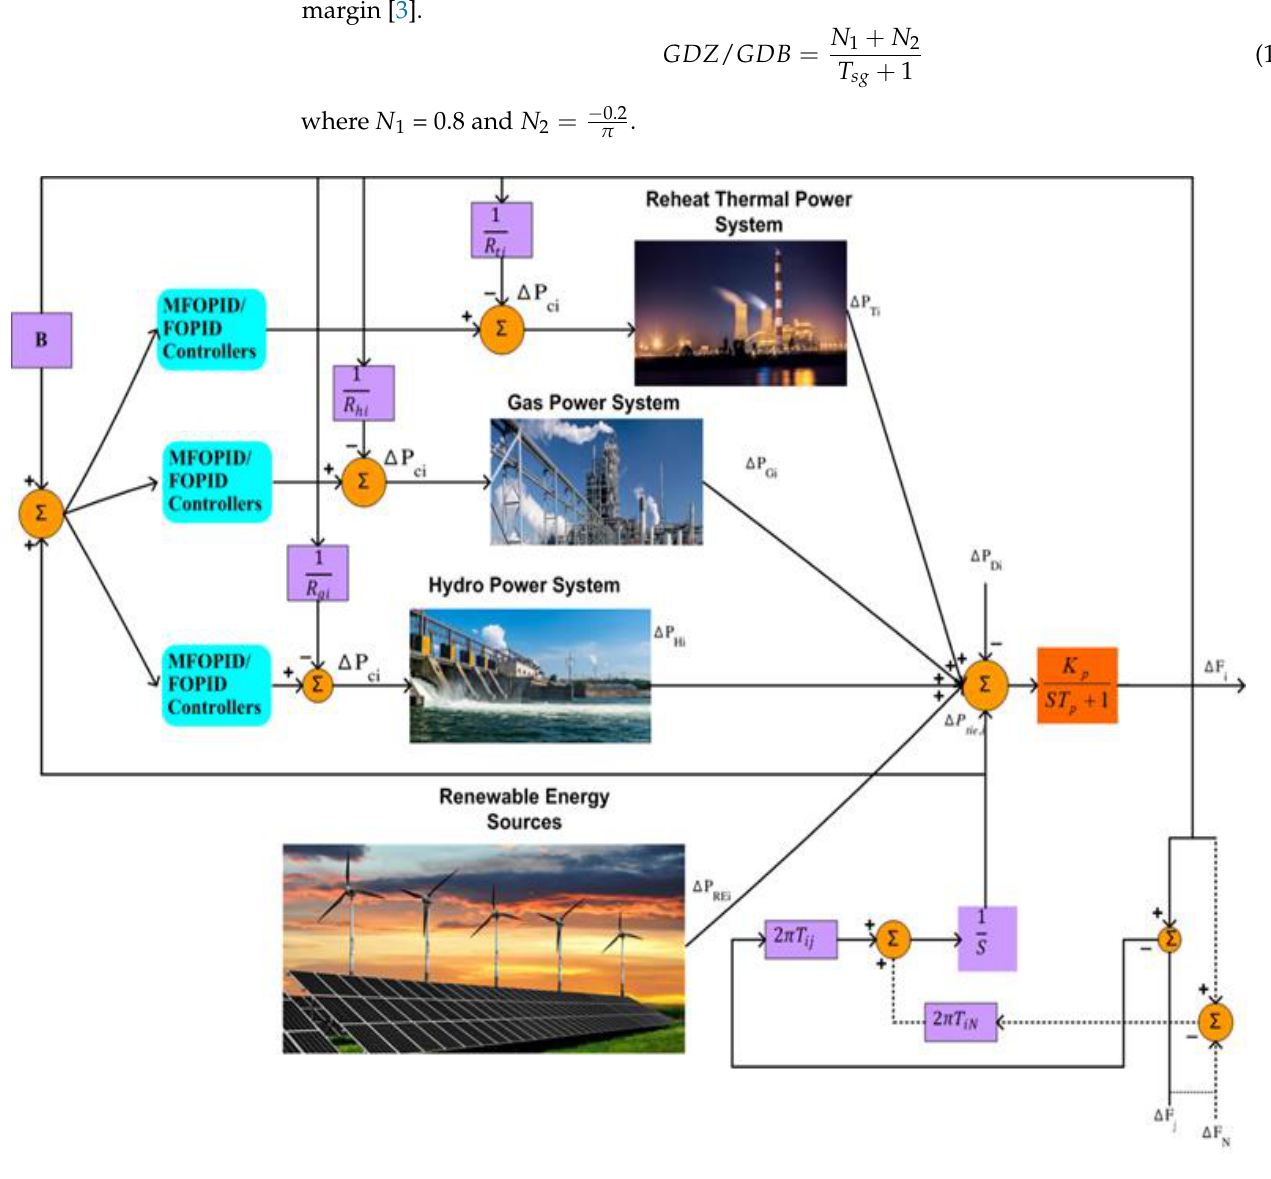
Figure 1. Schematic diagram of proposed power system.